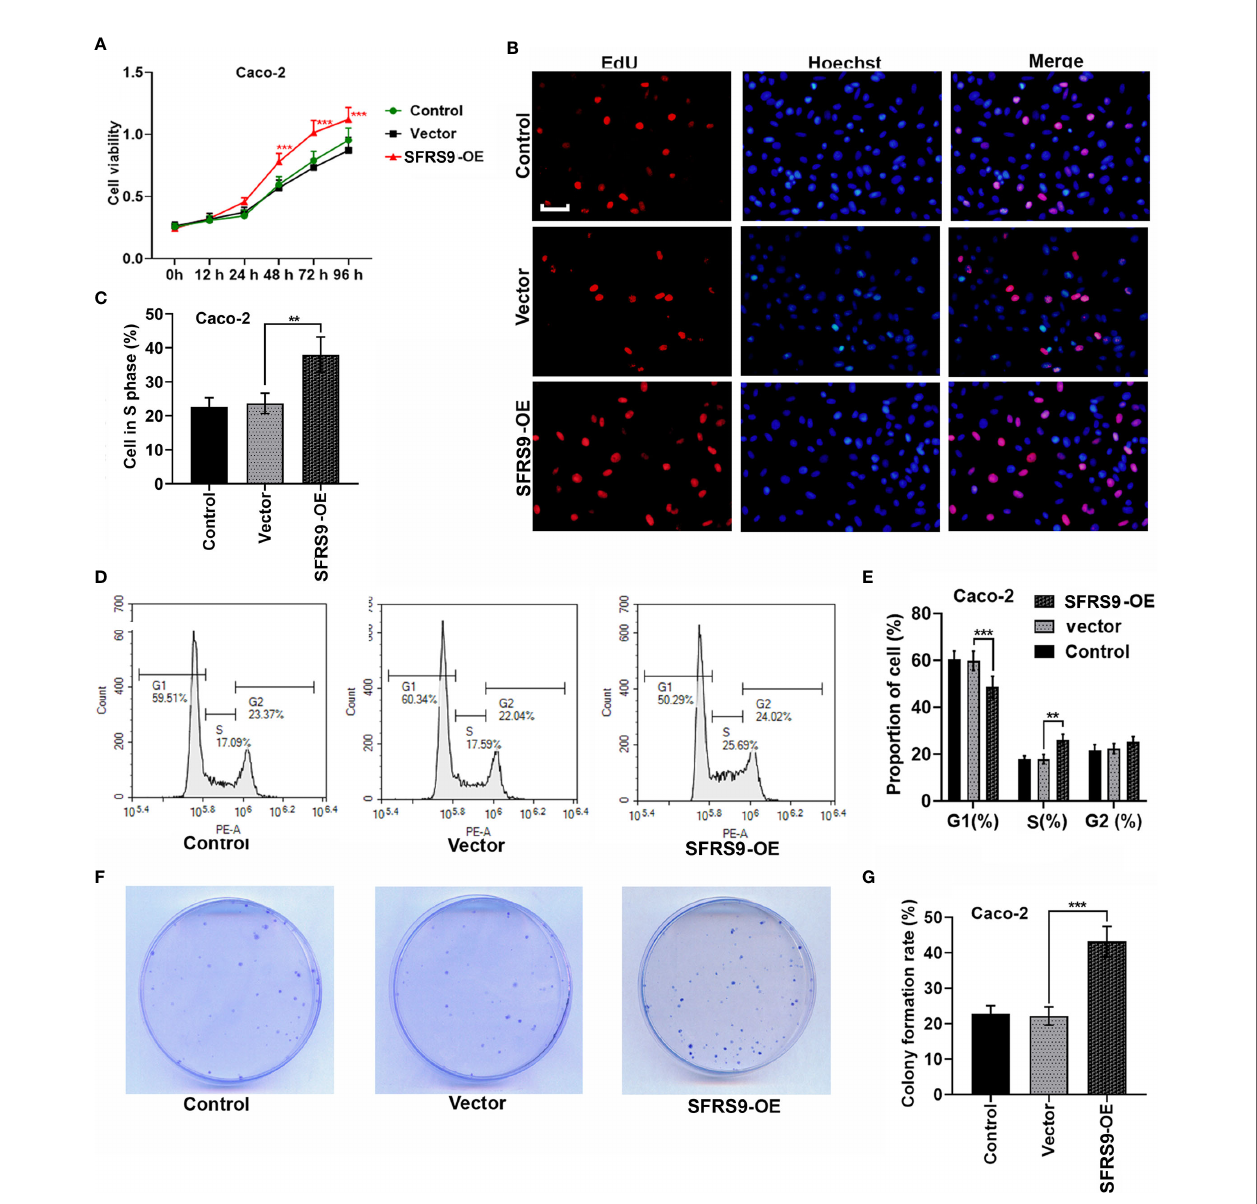
FIGURE 3 | SFRS9 promoted the growth of CRC cells. (A) The viability of Caco-2 cells was measured using the CCK-8 assay (***p < 0.001 vs. Vector group). (B, C) Representative images and data analysis of EdU staining of Caco-2 cells transfected with SFRS9-OE vector, Scale bars: 50 m m. (D, E) Cell cycle analysis in Caco-2 cells transfected with SFRS9-OE vector. (F, G) Colony formation of Caco-2 cells transfected with SFRS9-OE vector was assessed. Values are mean ± SD. **p < 0.01, ***p <